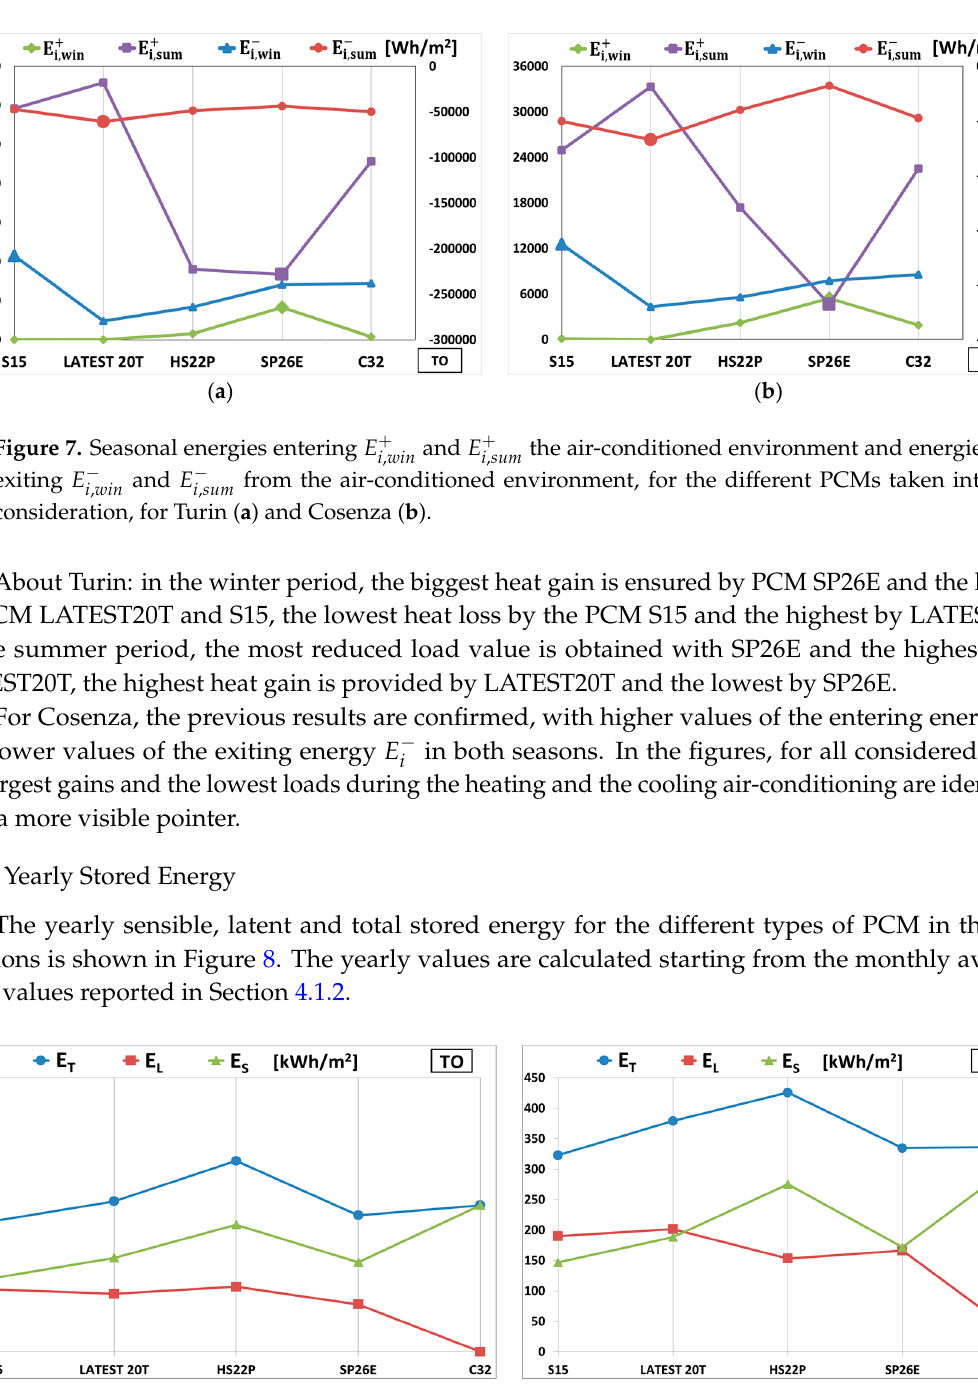
Figure 8. Yearly sensible E S , latent E L and total E T energy stored for the different PCMs. Values for Turin are on the left ( a ) and for Cosenza are on the right ( b ).